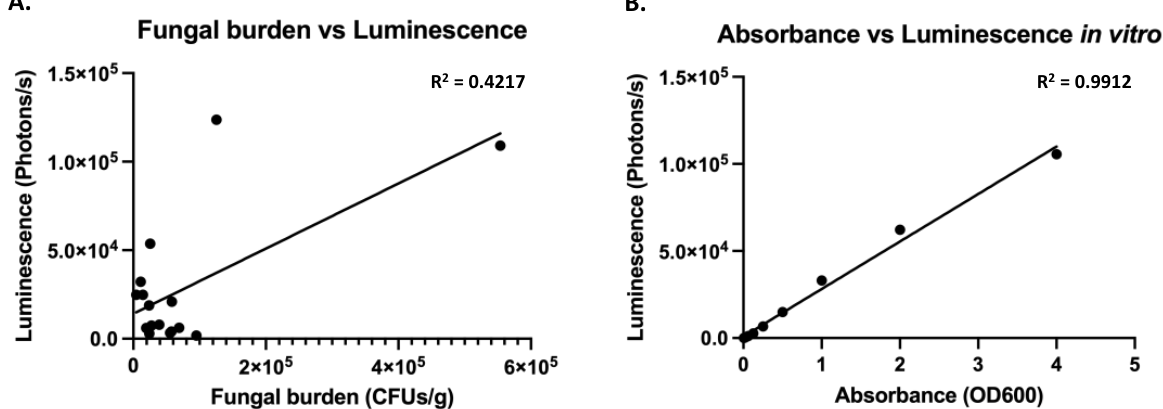
Figure 4. Luminescence does not correlate perfectly to fungal burden in vivo , even though good correlation exists in vitro (A) In vivo luminescence in the bladder was correlated to fungal burden using linear regression in Graph Prism. (B) In vitro measured luminescence was correlated to absorbance using linear regression in Graph Prism.